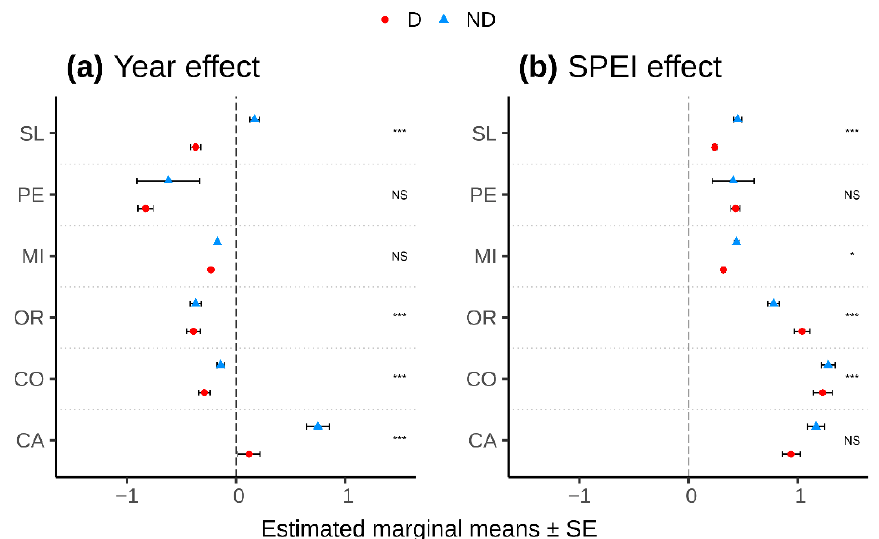
Figure 4. Estimated effects of ( a ) Year and ( b ) SPEI on growth depending on tree status (D, dead trees; ND, living trees). Values are estimated marginal means with standard errors (SE) according to the linear mixed-effect models. Significance levels: NS, not significant; * p <0.05, *** p < 0.001. See sites’ codes in Table 1.